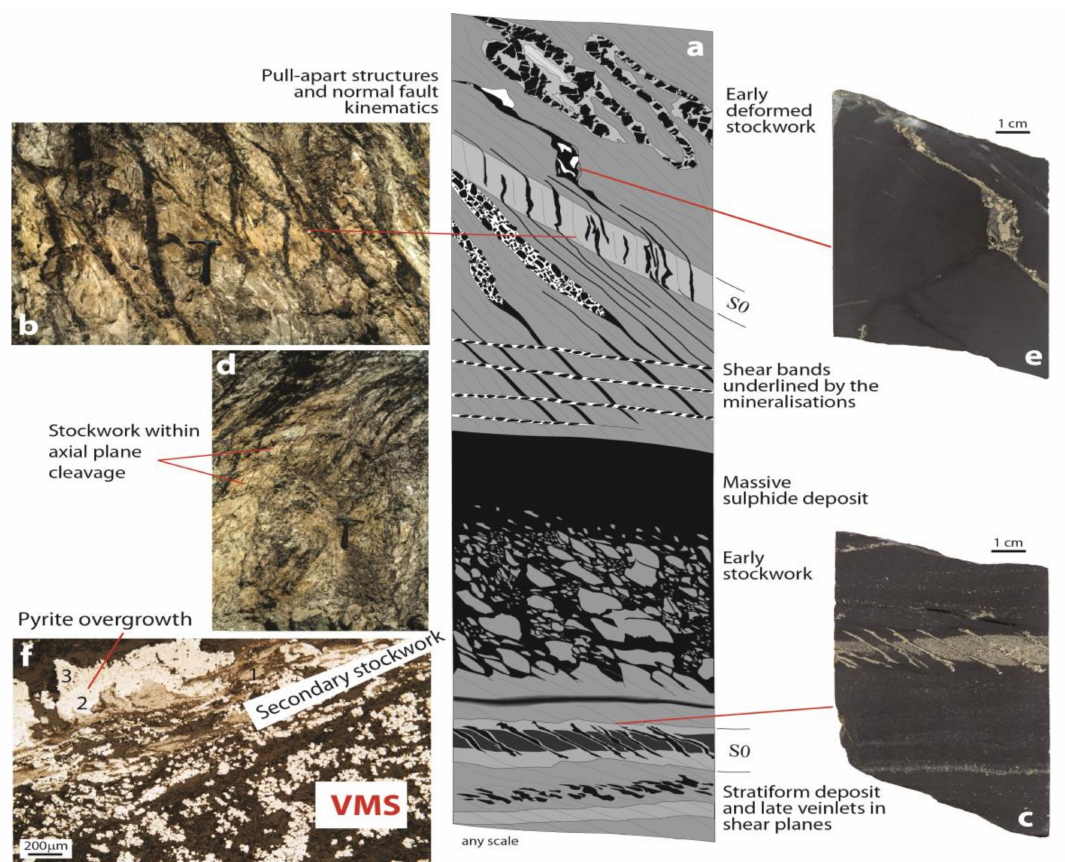
Figure 8. Schematic illustration showing the relationships between first stockwork and secondary one around the VHMS of the Iberian Pyrite Belt (south Spain). ( a ) Schematic distribution of the different stockwork and mineralised features close to a VHMS body. Occurrence of second stockwork within meter-scale shear bands ( b ) and within axial planar cleavage ( d ). ( c ) Stratiform pyrite-rich level cut by secondary pyrite-rich veins. ( e ) Small pull-apart filled by syntectonic quartz and pyrite. ( f ) Pyrite metablasts and overgrowths (2 and 3) formed close to a synkinematic second